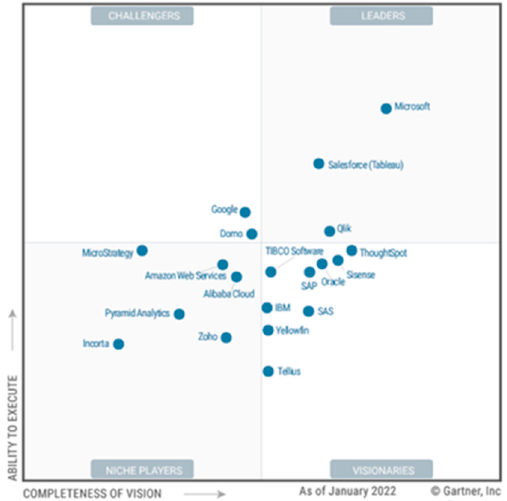
Figure 6. 2022 Gartner Magic Quadrant for Analytics and Business Intelligence Platforms.